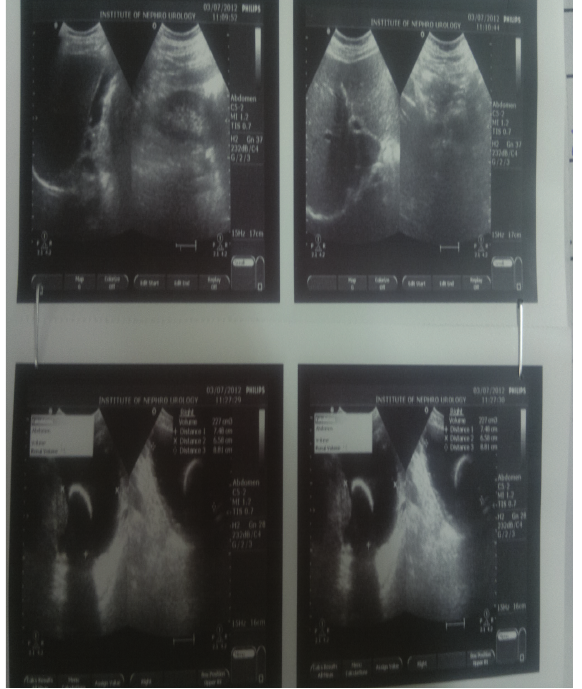
Figure 2: Ultrasonogram showing the giant calculus in bladder extending into urethra.